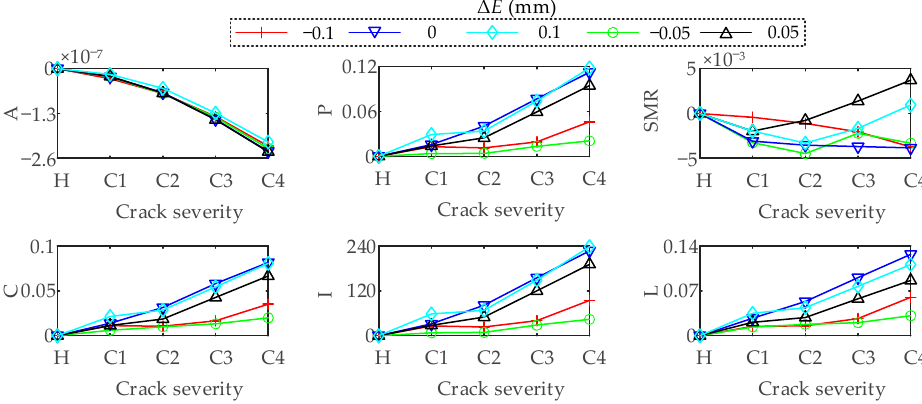
Figure 23. Under the influence of offset error, the fluctuation of time-domain indicators relative to their respective healthy condition values under different degrees of cracks.